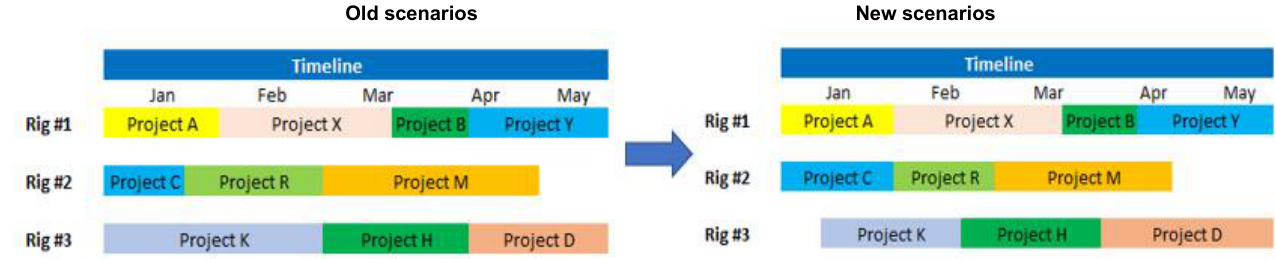
Figure 10—Drilling project timeline and number of rig allocation